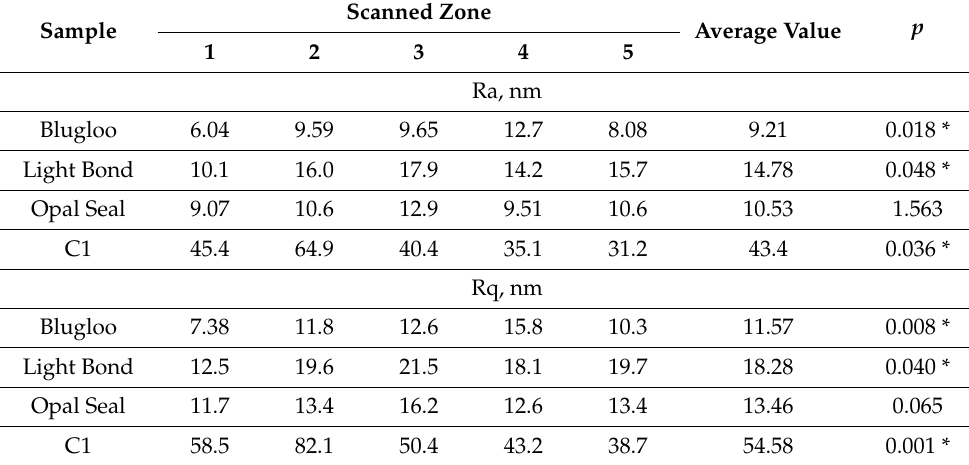
Table 4. Roughness values measured with AFM for the samples after 60 days.